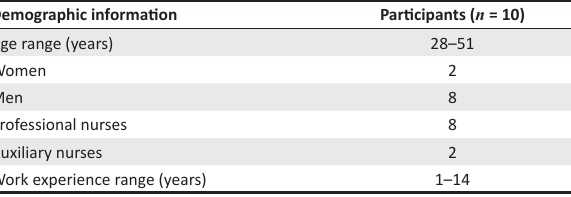
TABLE 3: Participants’ demographic